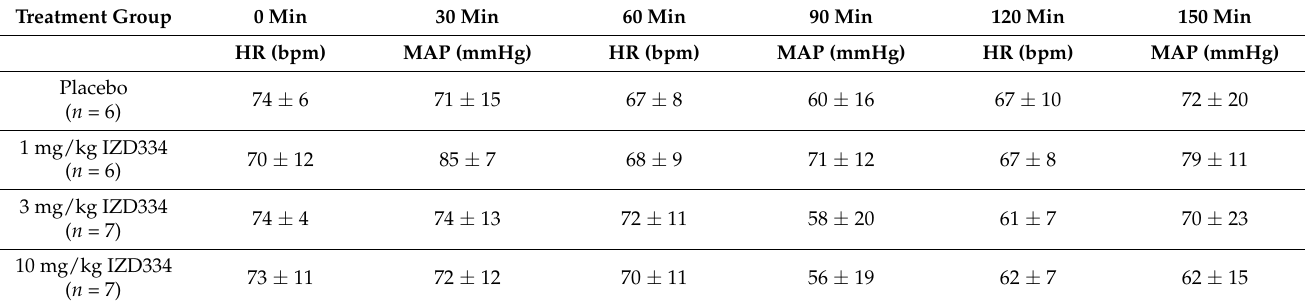
Table A2. Pharmacokinetic parameters and intravenous (IV) and oral (PO) concentration time profiles of IZD334 in pigs ( n = 3). Abbreviations: T1/2, half-life; MRT0-inf, mean residence